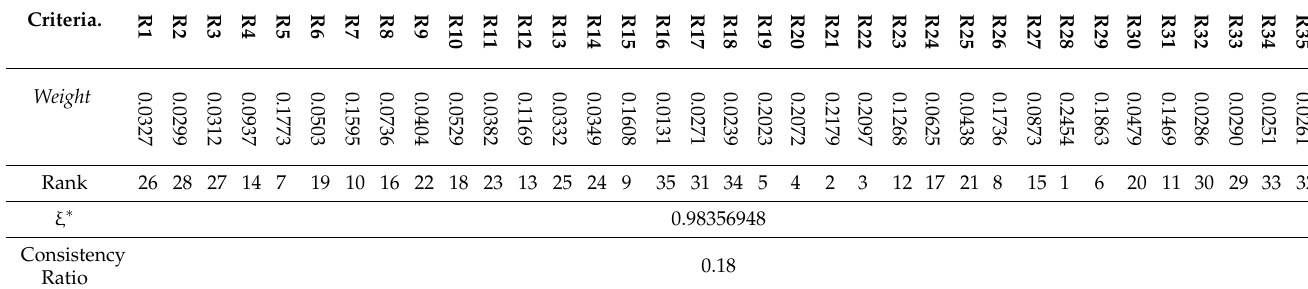
Table 7. The risks (cid:48)